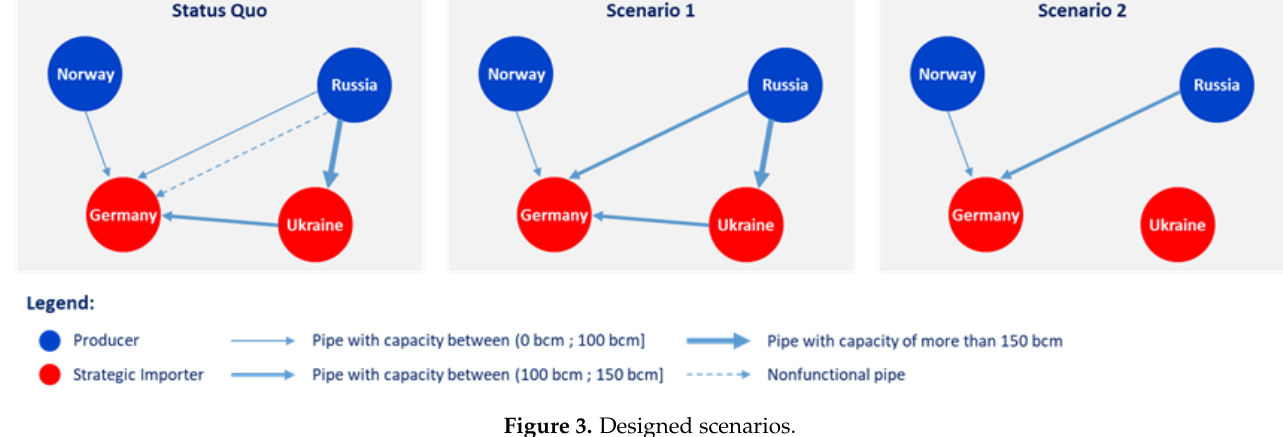
Figure 3. Designed Figure 3. Designed scenarios.